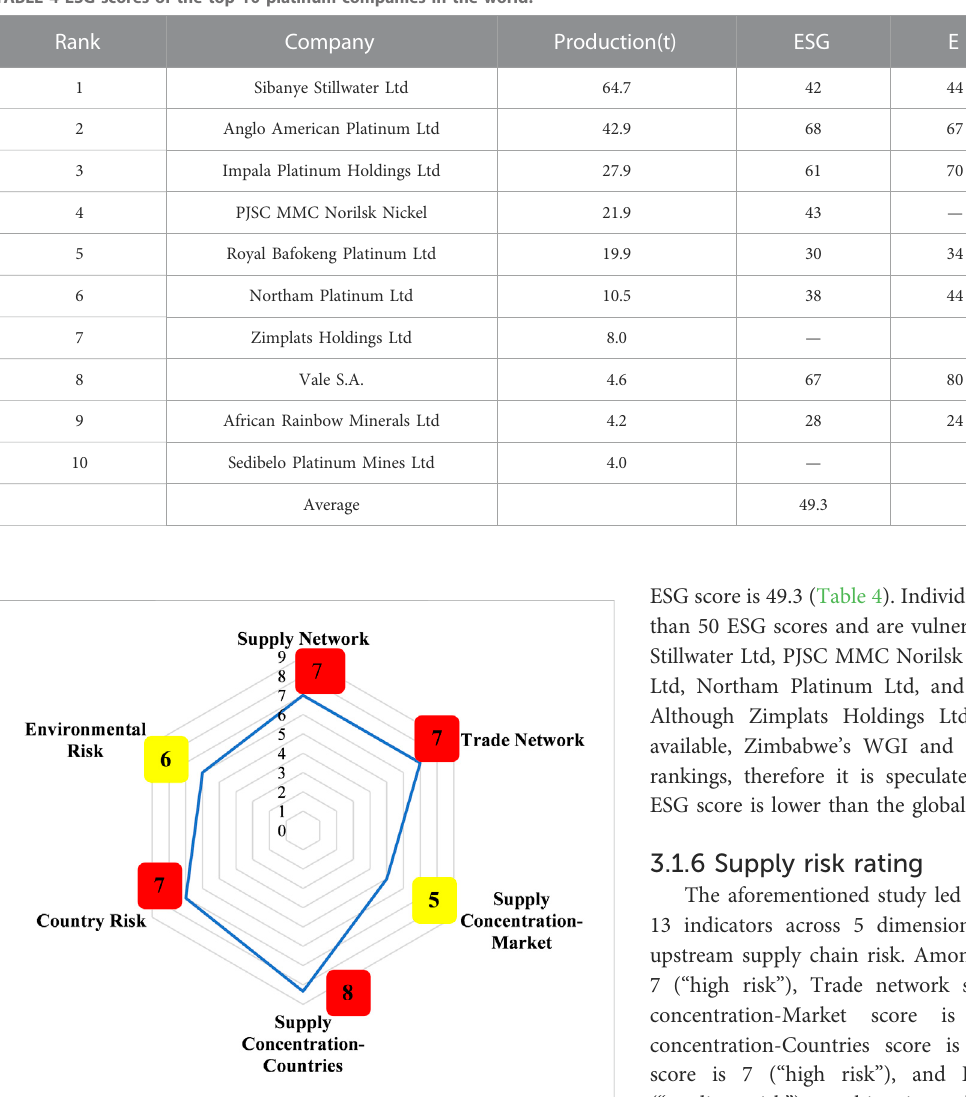
TABLE 4 ESG scores of the top 10 platinum companies in the world.